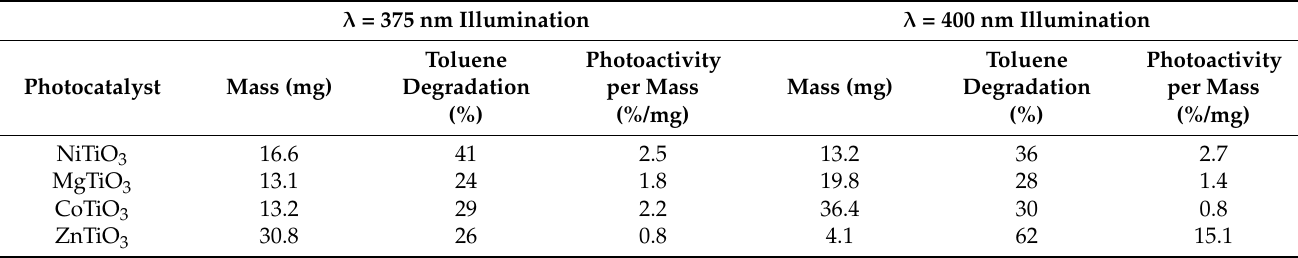
Table 4. Photoactivity per mass constants under LED illumination of metal titanate nanorods ATiO 3 (A = Mg, Co, Ni,